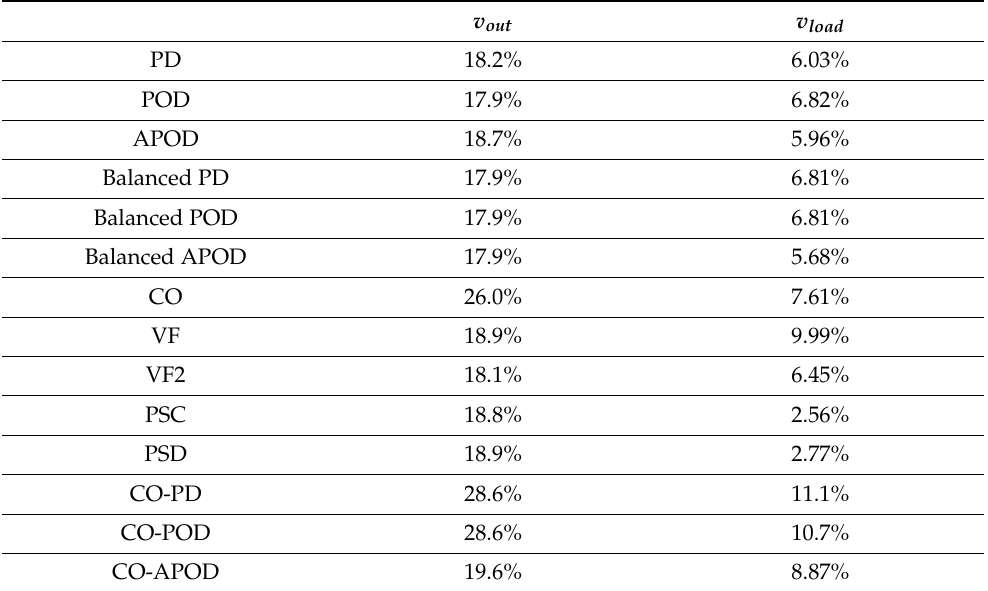
Table 7. Comparative THD % f values of the MMCC output voltage, v out , and the load voltage, v load , for different PWM